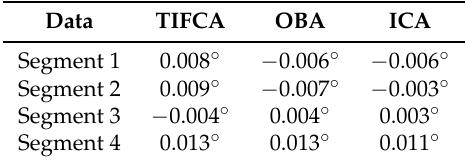
Table 4. The final pitch angle error of four segments.